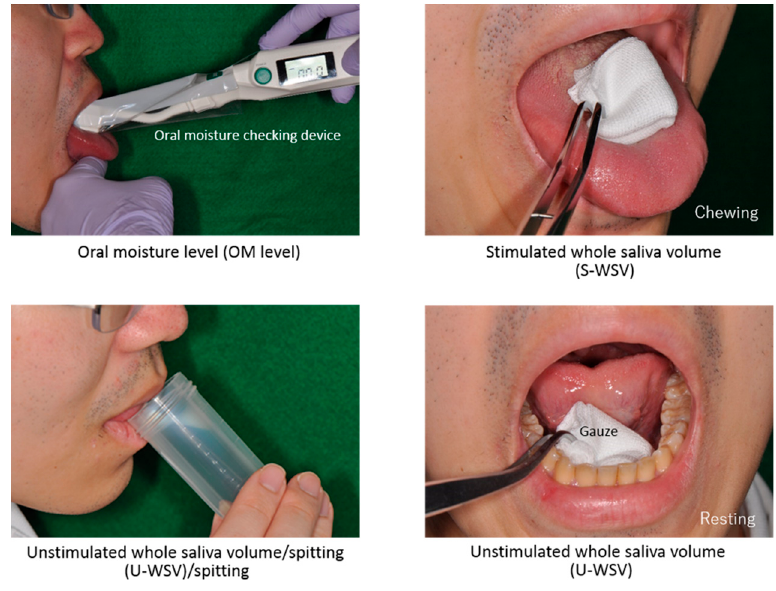
Figure 1. Outline of each measurement test (sialometry).